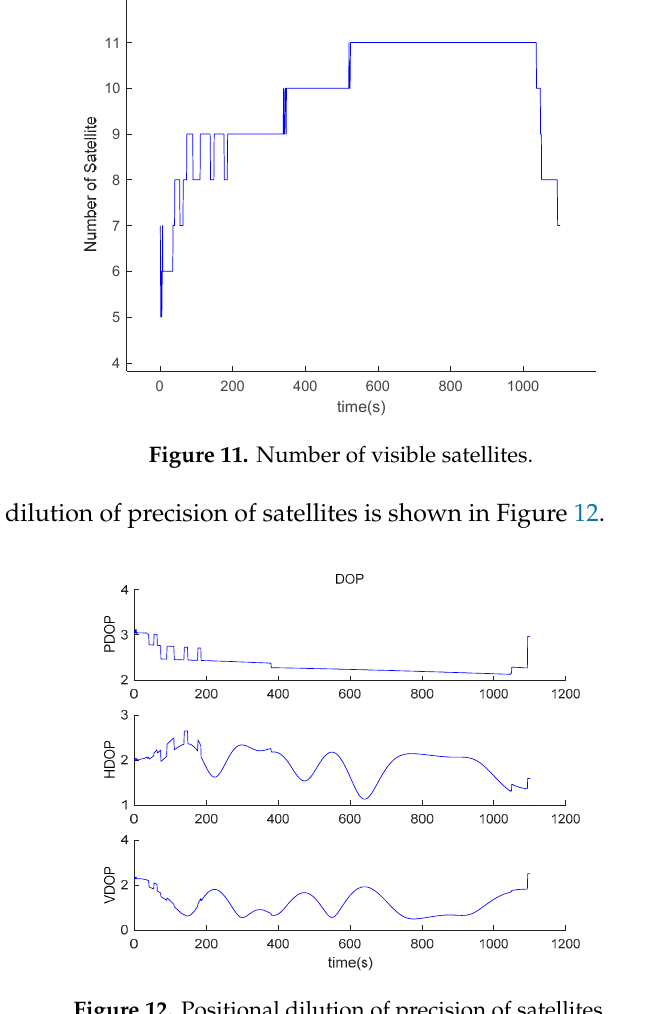
Figure 10. Output of gyroscope pulse output and gyroscope angular velocity.